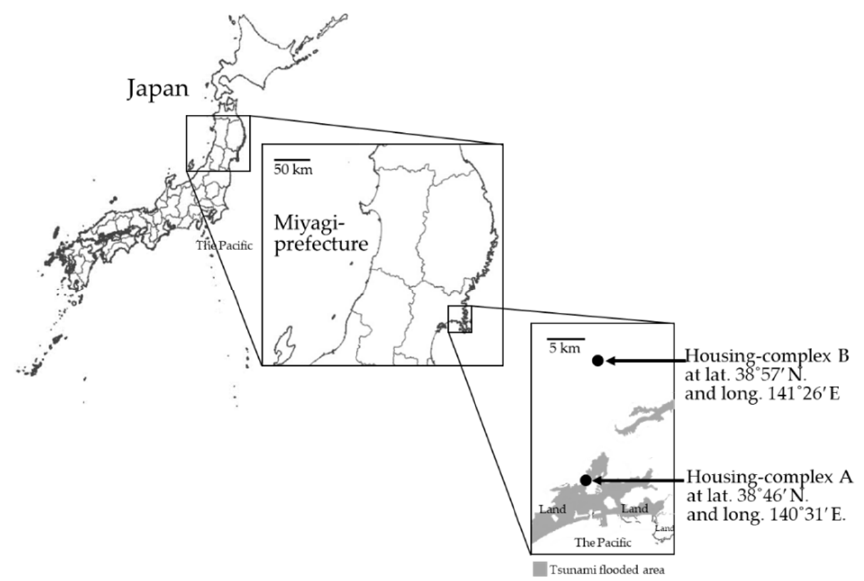
Figure 1. The map of the locations of two temporary housing-complexes tested in this study. This map is based on the GSI maps published by Geospatial Information Authority of Japan. The gray-colored area is tsunami flooded.